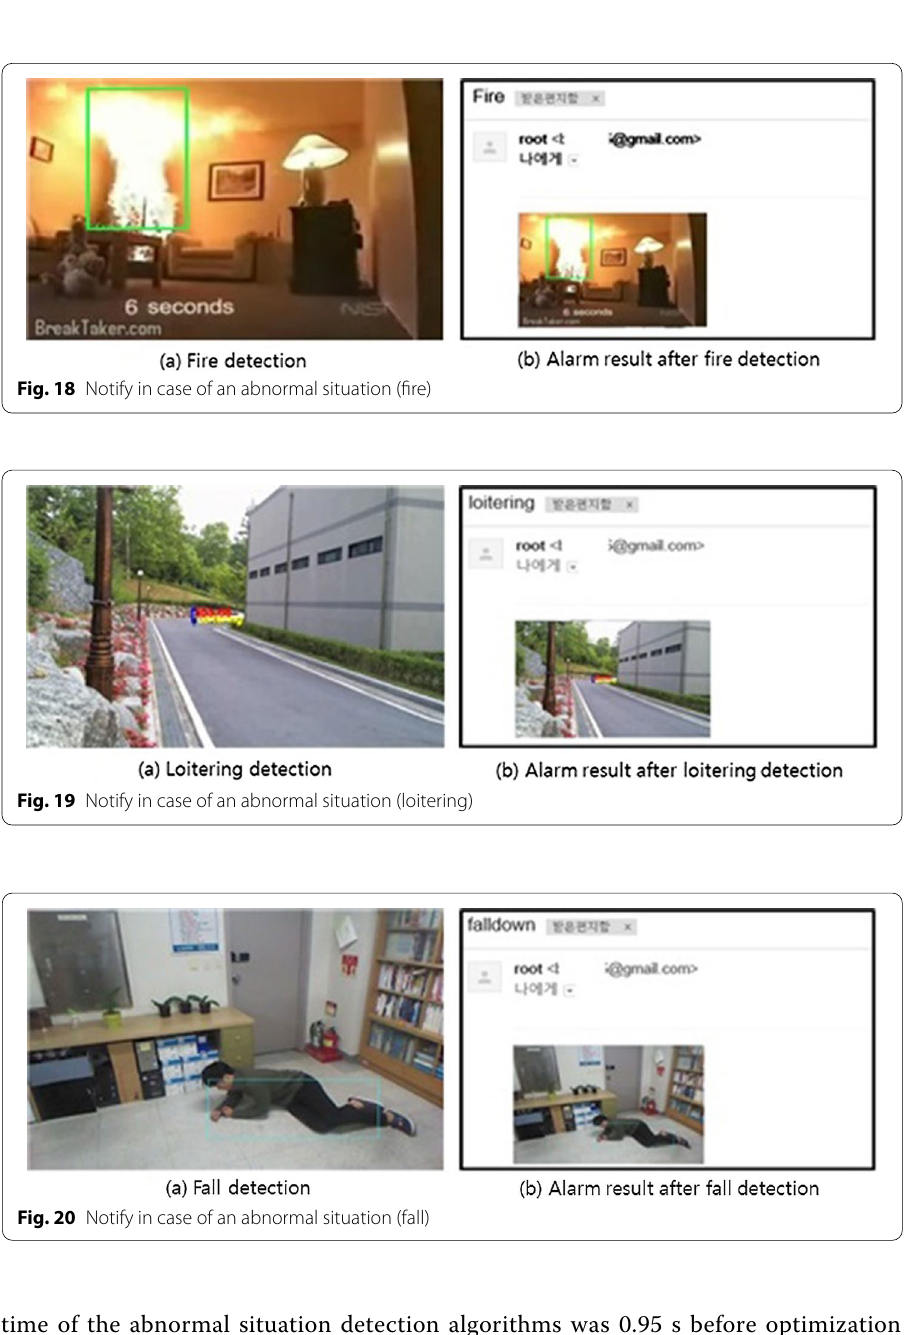
time of the abnormal situation detection algorithms was 0.95 s before optimization but 0.47 s after optimization, implying a decrease by 50.53%. When each abnormal situation detection algorithm was driven, the processing time of intruder detection algorithm was 0.58 s before optimization but 0.55 s after optimization, implying a decrease by 5.17%. The processing time of fire detection algorithm was 0.32 s before optimization but 0.24 s after optimization, implying a decrease by 25%. The process- ing time of loitering detection algorithm was 0.21 s before optimization but 0.15 s after optimization, implying a decrease by 28.57%. The processing time of fall detec- tion algorithm was 0.2 s before optimization but 0.15 s after optimization, imply- ing a decrease by 25%. Therefore, we confirmed the real-time operation and various